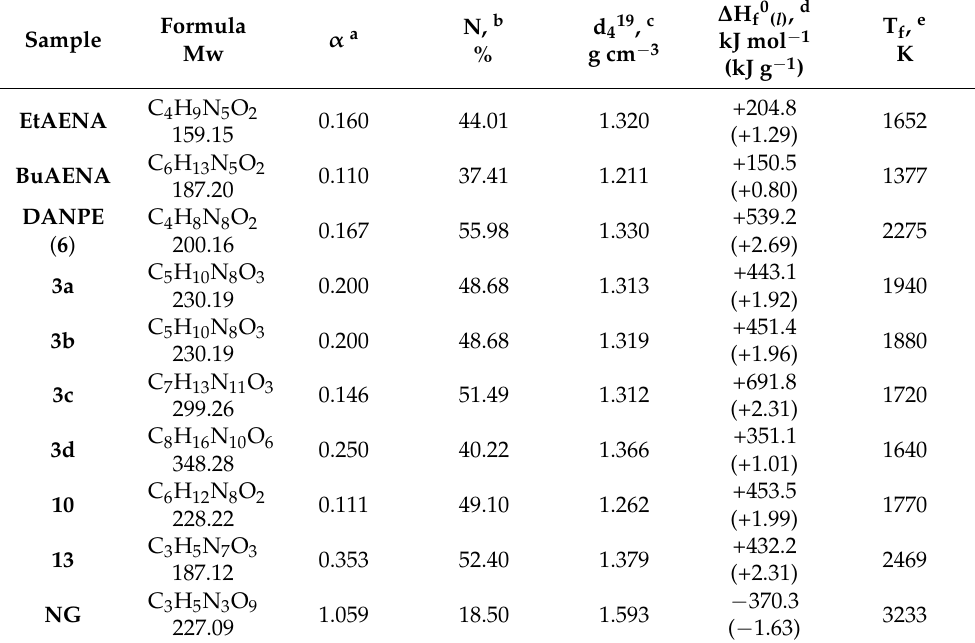
Table 8. Some properties of compounds of this study in comparison with benchmark plasticizers.